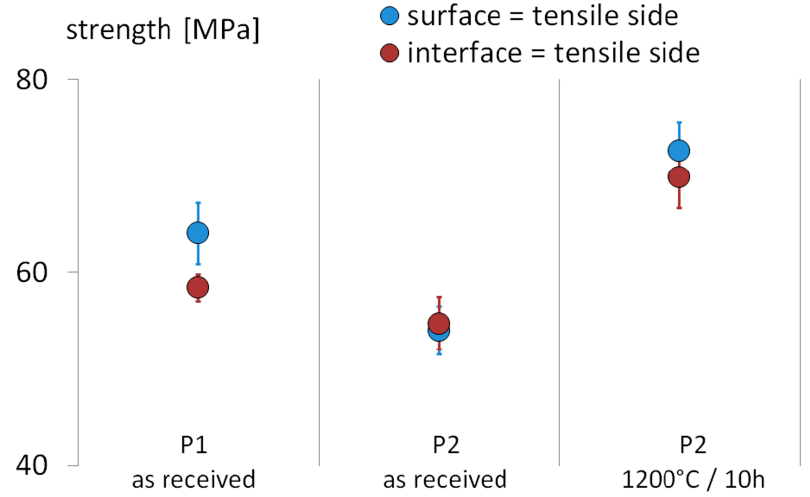
Figure 8. A comparison of the bending strength with respect to the orientation of the tensile side, for different plates and aging conditions.